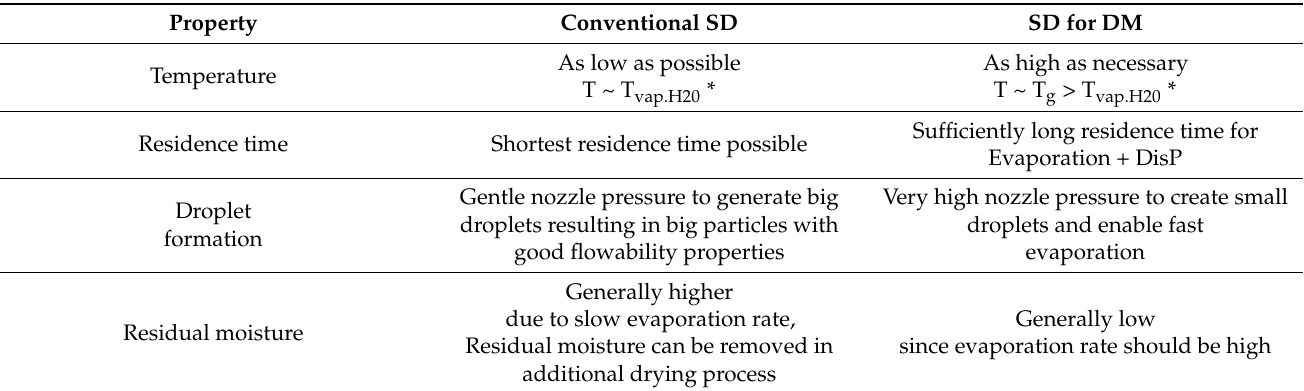
Table 4. Conventional SD vs. SD for